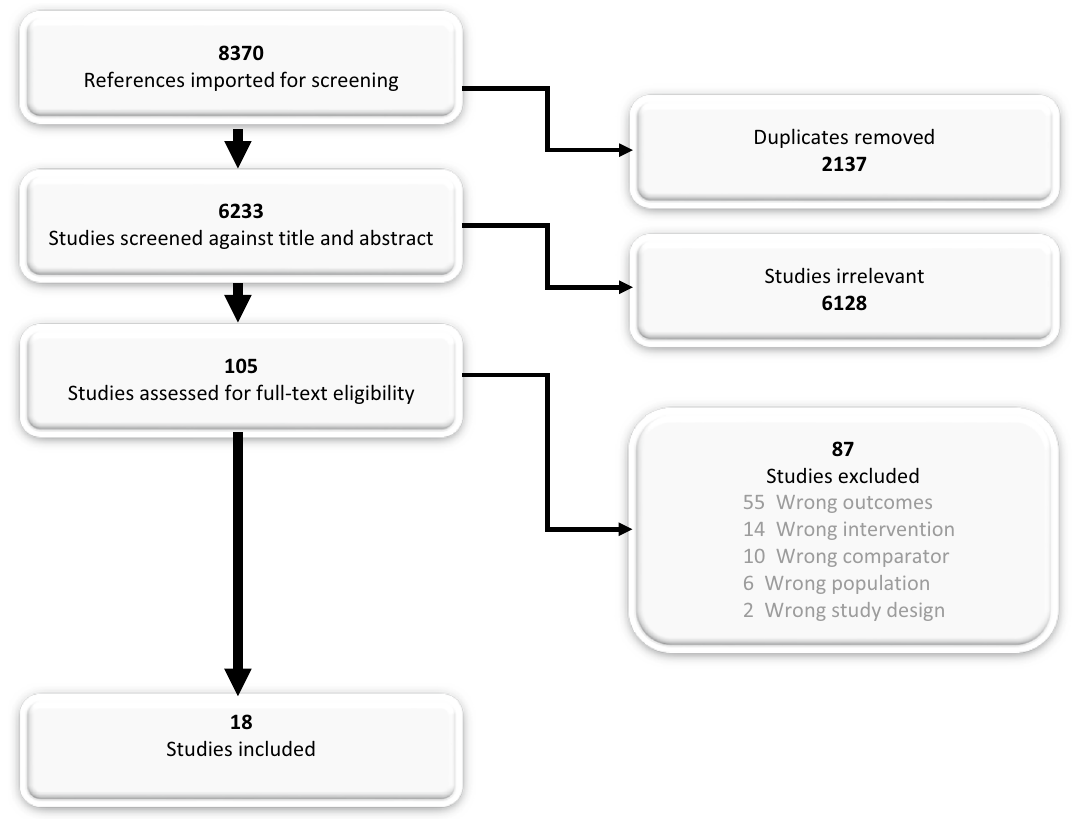
Fig. 1 PRISMA flow chart of literature screening for inclusion. From